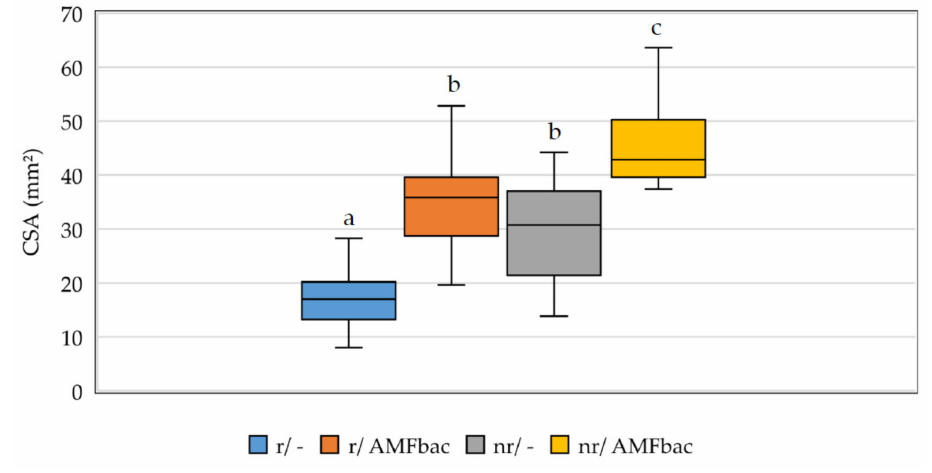
Figure 4. AMFbac Pot Experiment A-CSA (mm 2 ), November 2017 (week 32), α =